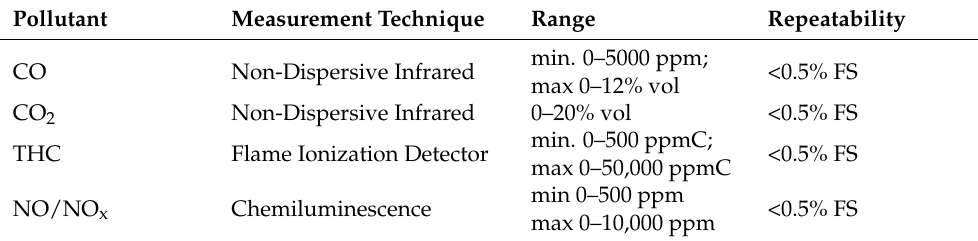
Table 2. Horiba MEXA 7100 DEGR specifications.